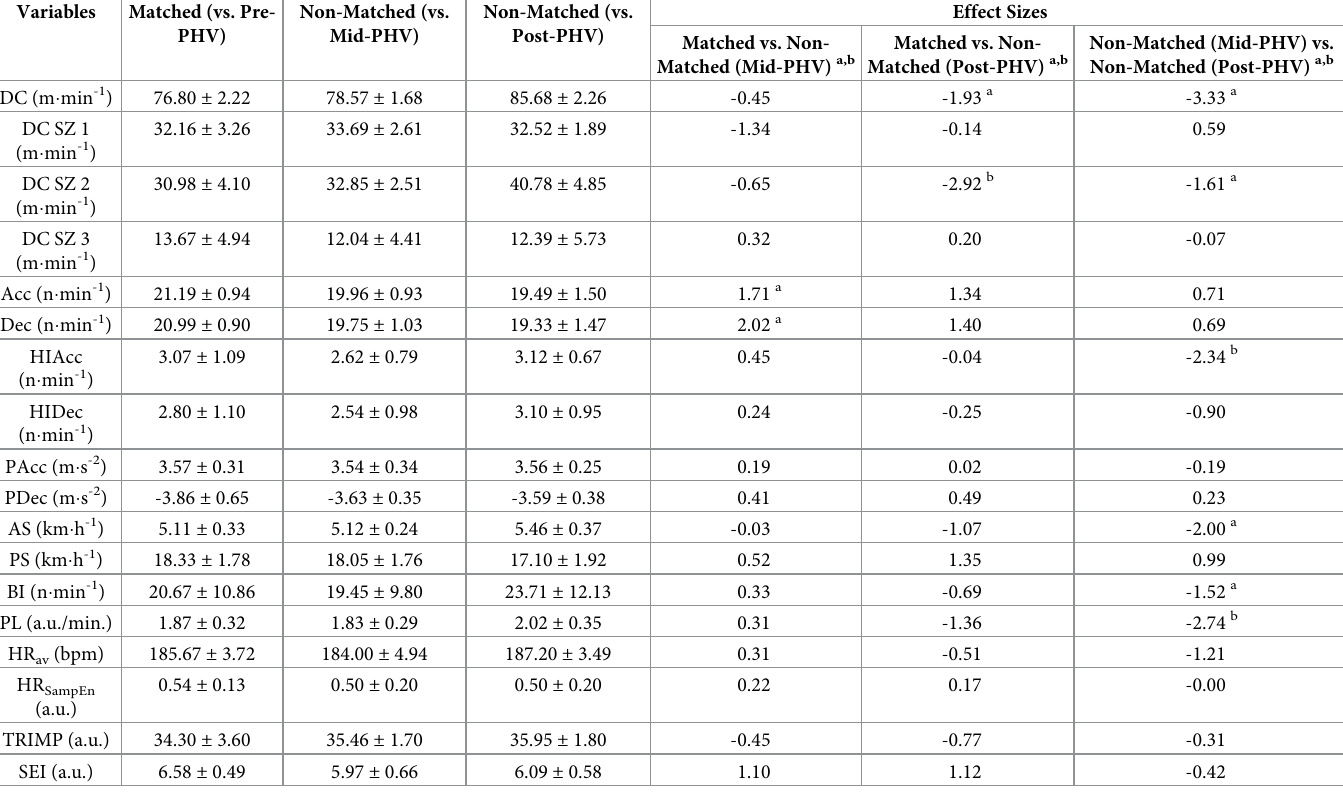
Table 2. Mean ( ± SD) physical and tactical performance produced by Pre-PHV during game formats. Variables Matched (vs. Pre- PHV)